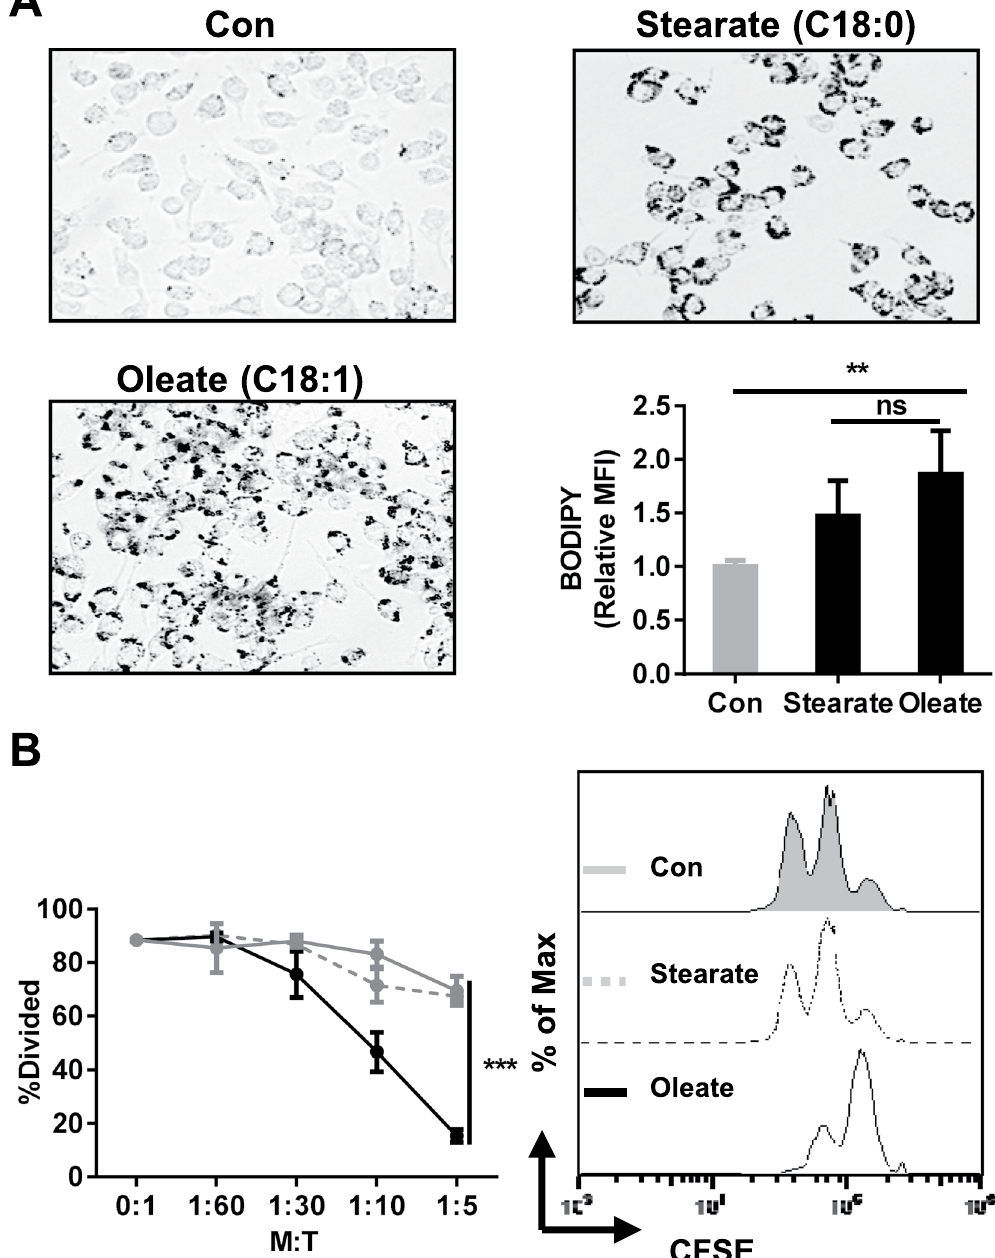
Figure 2. Sodium oleate but not stearate induces a suppressive phenotype in MSC-2 cells. MSC-2 cells were incubated for 24 h with either sodium oleate (0.2 mM) or stearate (0.2 mM). The accumulation of lipid droplets was detected either microscopically via oil-red-O ( × 20), or by BODIPY staining and flow cytometry ( A ). To assess the inhibitory effect of either sodium oleate or stearate, MSC-2 cells, pre-treated with the respective FFA, were subsequently co-cultured with purified CD4 + T cells at the ratios indicated. T cell proliferation was analyzed by CFSE staining after 72 h ( B ). Shown is the mean ± SD from three to four independent experiments. ** p ≤ 0.01; *** p ≤